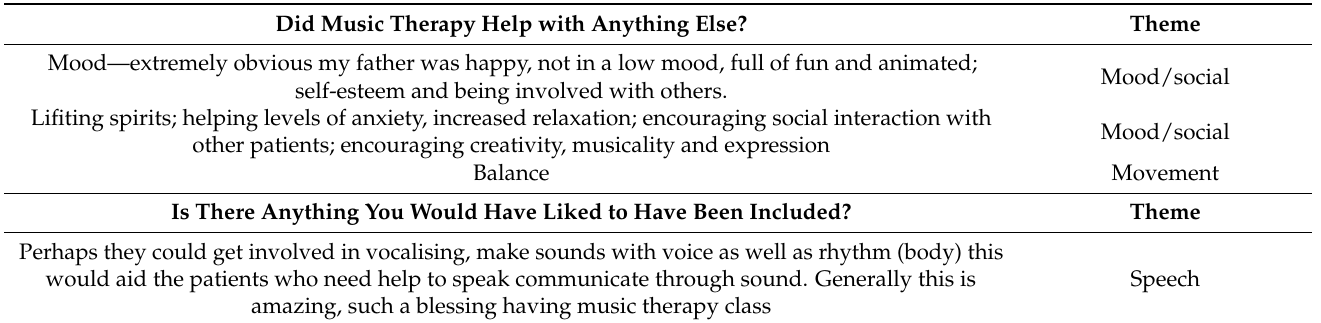
Table A3. Relatives’ qualitative responses to feedback questionnaire ( n =